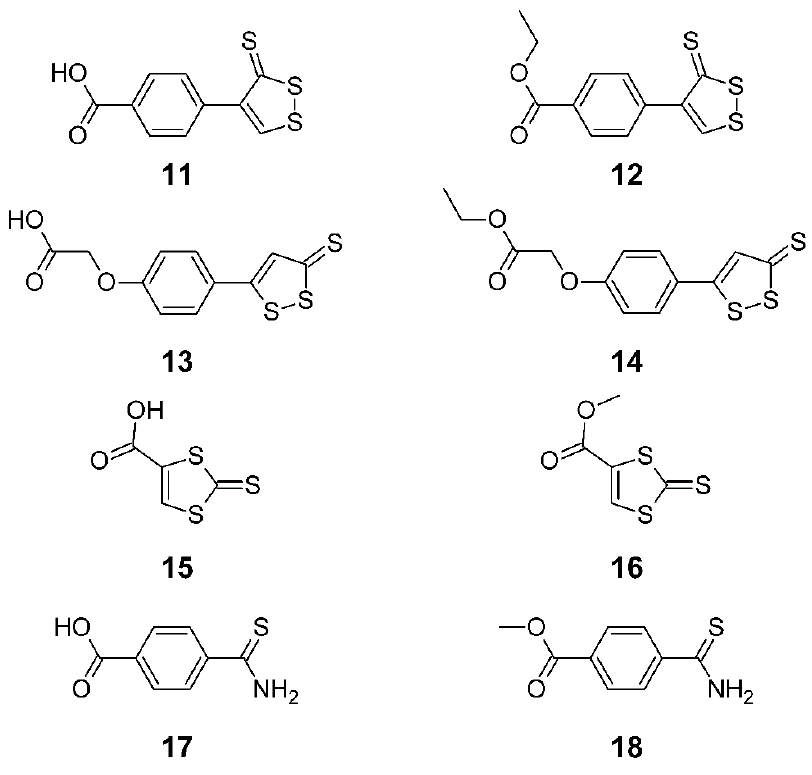
Figure 1. Structures of H 2 S donor molecules.